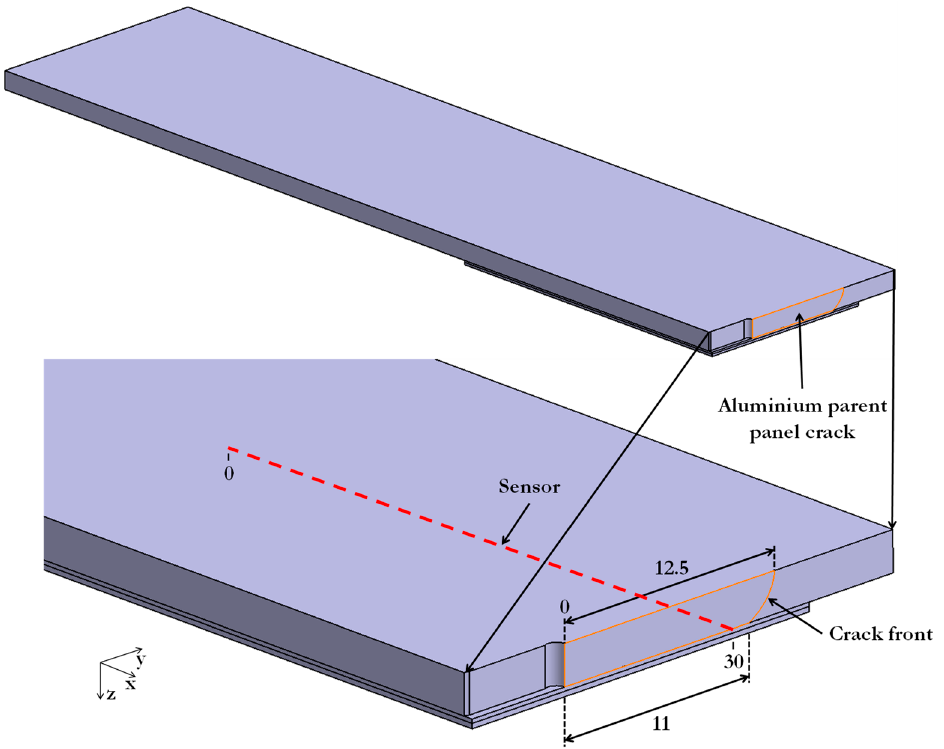
Figure 12. 3D schematic of the damaged model showing a crack of 12.5 mm.